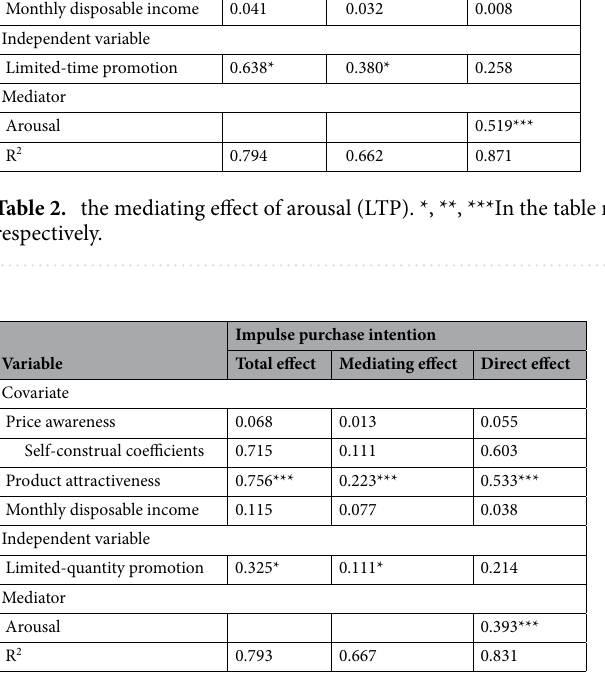
Table 3. The mediating effect of arousal (LQP). *, **, ***In the table represent P < 0.05, 0.01 and 0.001 respectively.